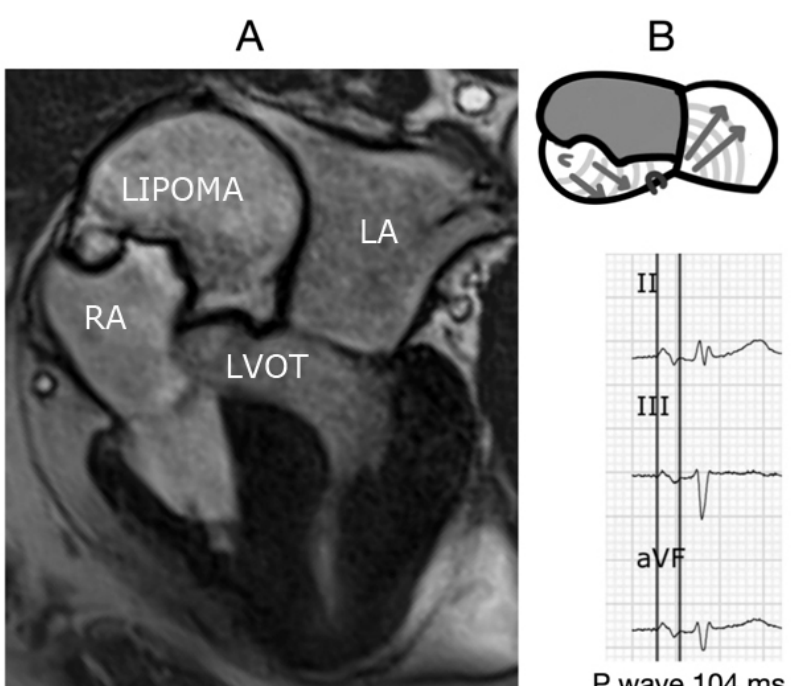
Figure 11. ( A ) and ( B ) A case of a 73-year old man found to have a large lipoma (4 × 5 Figure 11. ( A , B ) A case of a 73-year old man found to have a large lipoma (4 × 5 cm) located on the cm) located on the interatrial septum. Cardiac magnetic resonance imaging allowed for interatrial septum. Cardiac magnetic resonance imaging allowed for complete characterization. As complete characterization. As the atrial fibrosis is not extended in all atria, the duration of the atrial fibrosis is not extended in all atria, the duration of the P-wave in spite of A-IAB is <120 ms. (Taken from reference